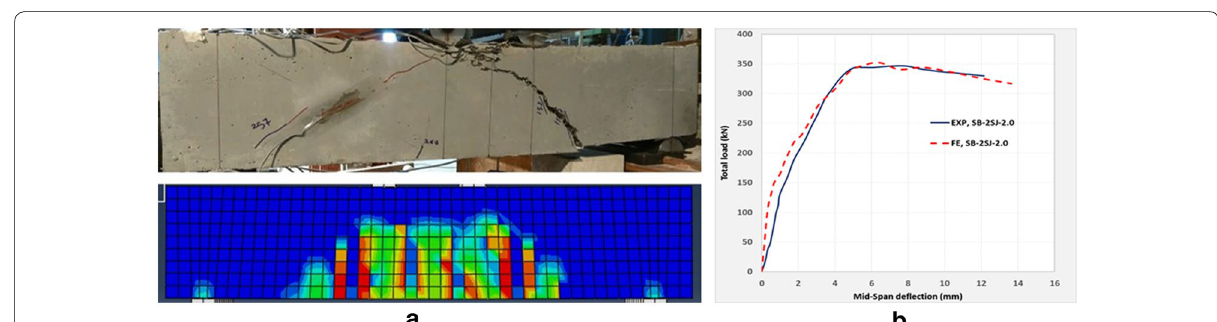
Fig. 23 Control beam (CT‑2.0): a failure mode, b load–deflection response.